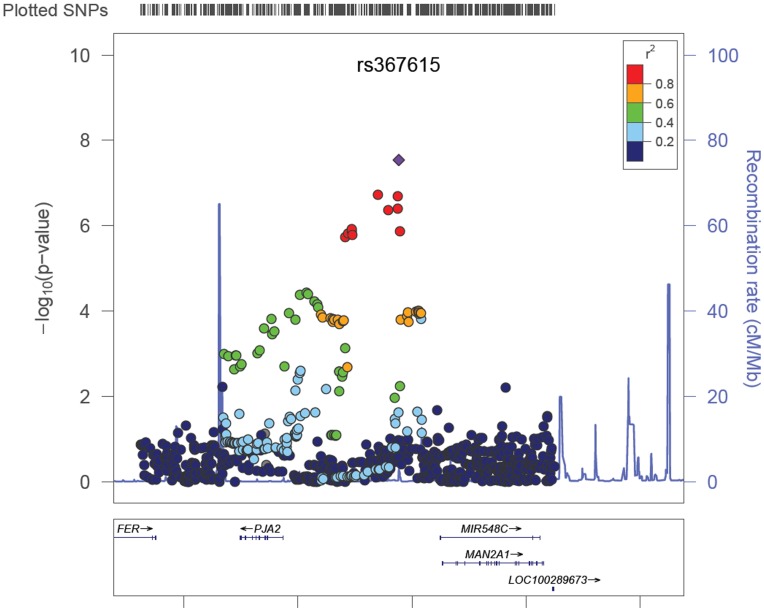
Forest plot for meta-analysis results of GxG between rs1571218 and rs10879357.Box sizes are proportional to the inverse variance for each study and the lines depict the confidence intervals. The diamonds represent the fixed effects meta-analysis results, with the width of the diamond representing the confidence interval. The results of two advanced adenoma studies (HPFS Adv Adnm and NHS Adv Adnm) are shown at the bottom but not incorporated in the meta-analysis.